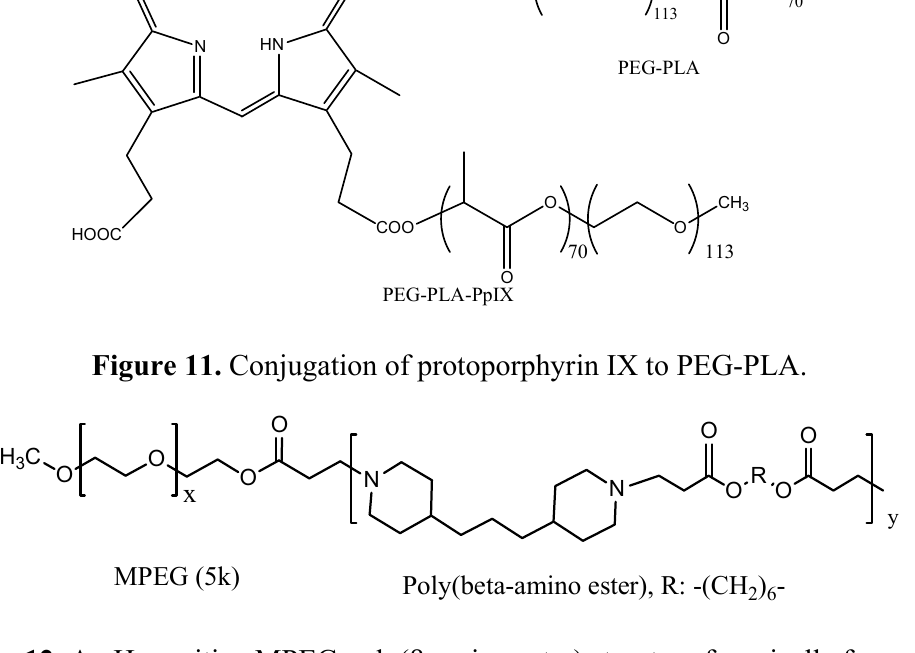
Figure 12. A pH sensitive MPEG poly( β -amino ester) structure for micelle